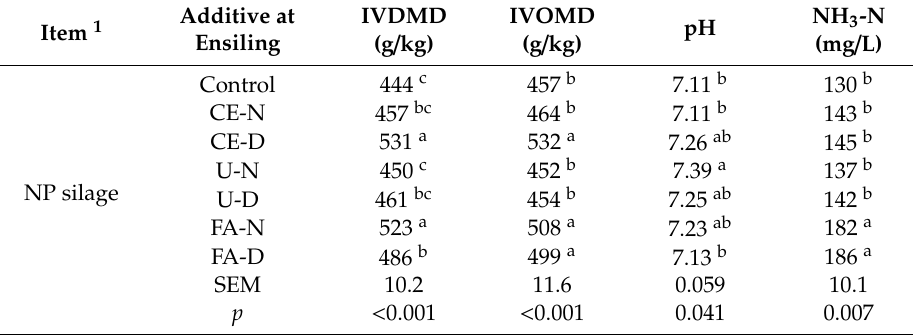
Table 6. In vitro digestibility, pH and ammonia nitrogen concentration after 48 h incubation of silages after 30 d of